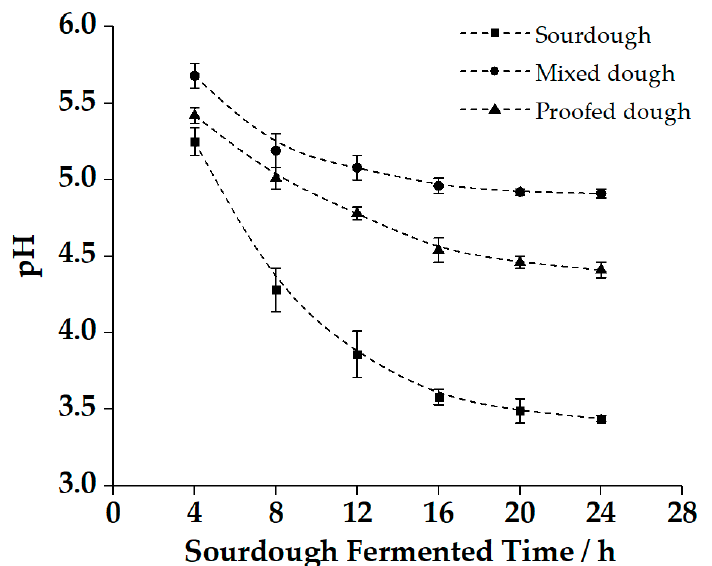
Figure 1. Final pH of sourdough, mixed dough, and proofed dough. The mixed dough and proofed dough were prepared by corresponding sourdough with different fermentation times: 4–24 h. All data are the means ± standard deviation.